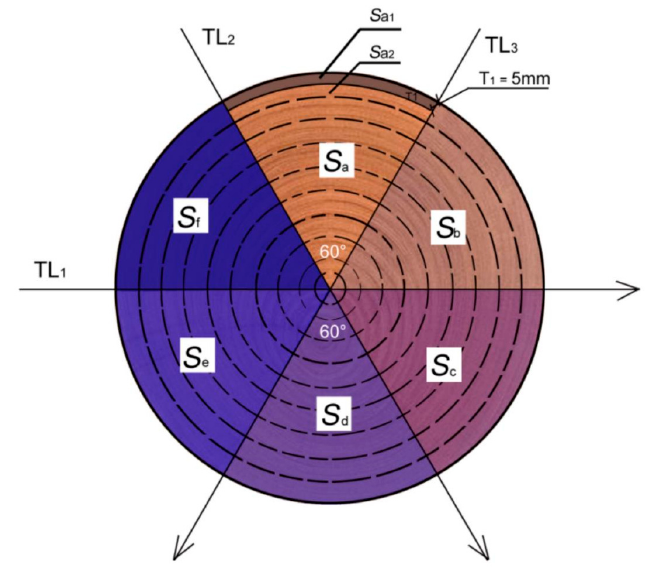
Figure 15. Strength schematic diagram of test section division.